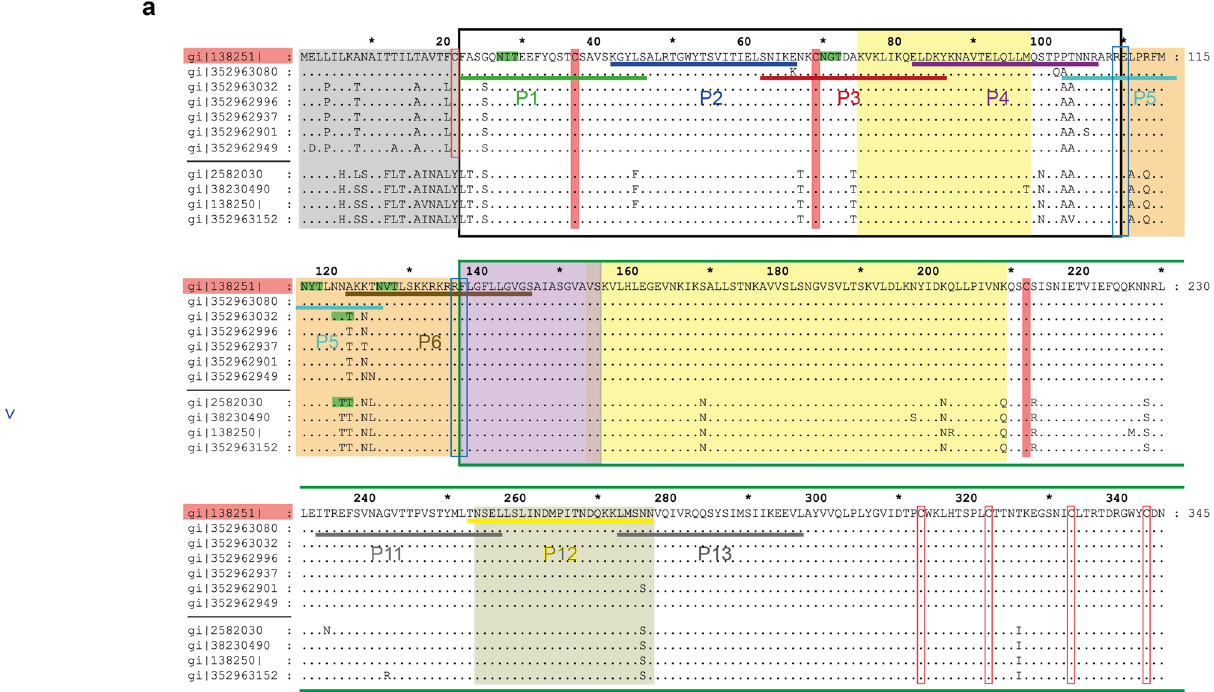
Figure 1. Illustration of A2 strain-derived recombinant F2-, F0-proteins and synthetic peptides. Alignment of the amino acid sequence of F0 from the A2 strain, subgroup A (top line), with the most variable strains from the two antigenic subgroups, A and B. Accession numbers for subgroups A and B (https ://www.ncbi.nlm.nih. gov/) on the left margin are separated by a black horizontal line, amino acid numbers are indicated on top and on the right margin ( a , b ). Identical amino acids are indicated by dots, conserved cysteines are indicated by red boxes. Cysteines forming disulfide bonds between the F1 fragment (green box) and F2 fragment (black box) are indicated as filled red boxes whereas other cysteines are shown by open red boxes. The two furin cleavage sites (amino acid aa 109–110; aa 136–137) are indicated by blue boxes and predicted N-linked glycosylation sites are highlighted in green. The following parts are indicated: Signal peptide (grey box), heptad repeats HR1-3 (yellow boxes), cleaved peptide P27 (orange box), fusion peptide FP (purple box), transmembrane domain (brown box), cytoplasmic tail (blue box) and palivizumab binding site (khaki box). Synthetic peptides (P1, P2, P3, P4, P5, P6, P11, P12 and P13) are shown with horizontal bars. Schematic diagram of the complete fusion protein with disulfide bonds between the F2 and F1 fragment ( c ). Different parts are colored as in ( a , b ). Recombinant F2-P27 and F0 with C-terminal hexahistidine tails are indicated